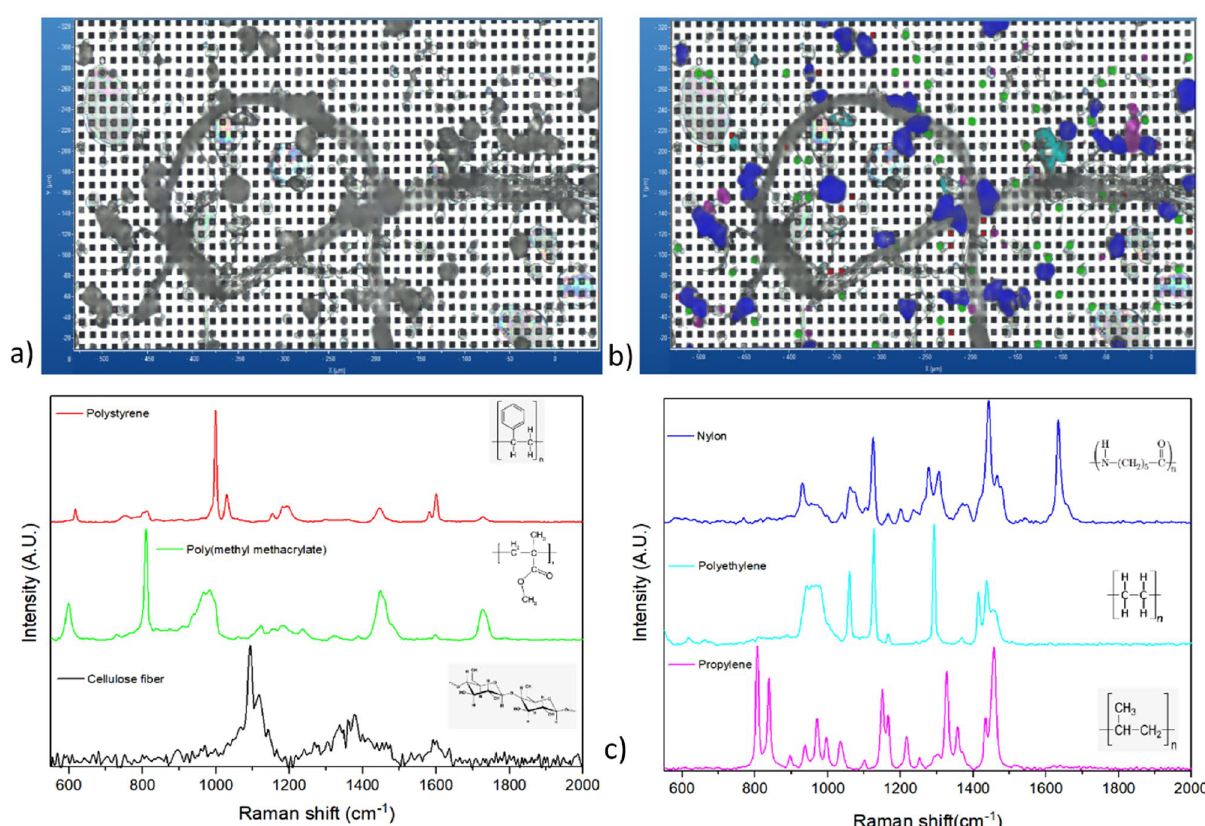
Figure 4. µRaman analysis of a part of the filtered area for a cow’s milk (brand C, skimmed milk, 0.1% fat) spiked with 5 standards of MPs: ( a ) optical microscope image of digested particles on a part of the Si filter; ( b ) Same image with MPs and cellulose fiber detected and identified (PS colored in red, PMMA in green, cellulose fiber in gray, PA in blue, PE in cyan and PP in pink); ( c ) related colored Raman spectra collected from 5 MP standards and cellulose fiber after sample digestion.